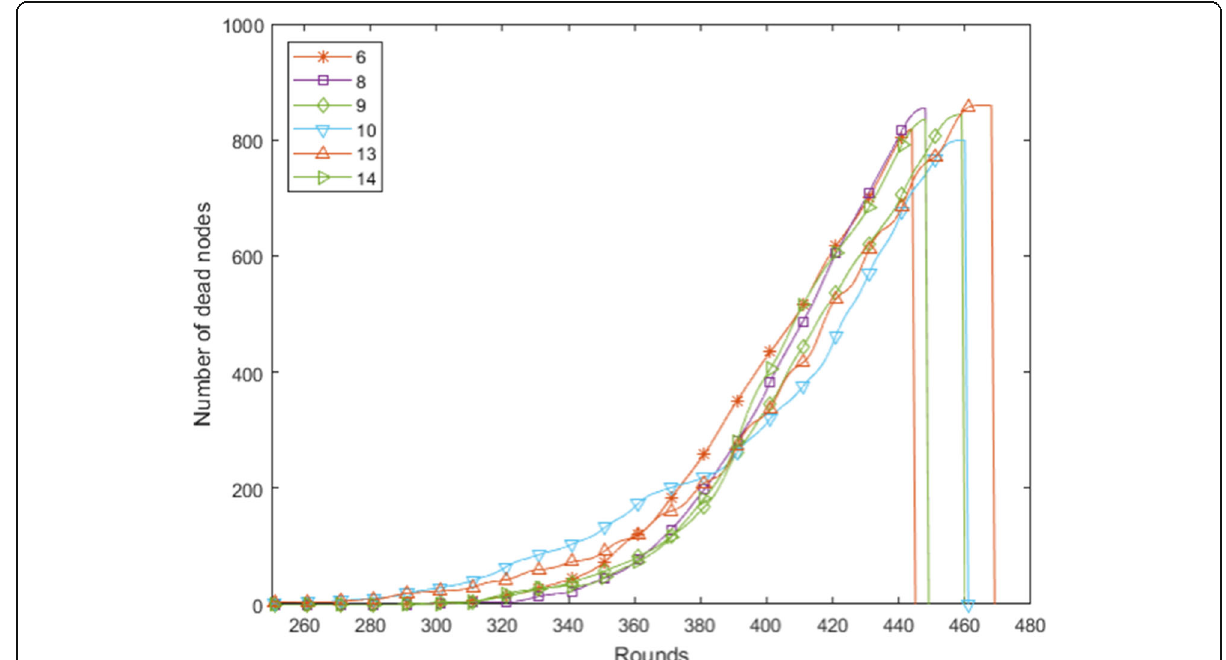
Fig. 6 Network life cycle under different cluster head rotation